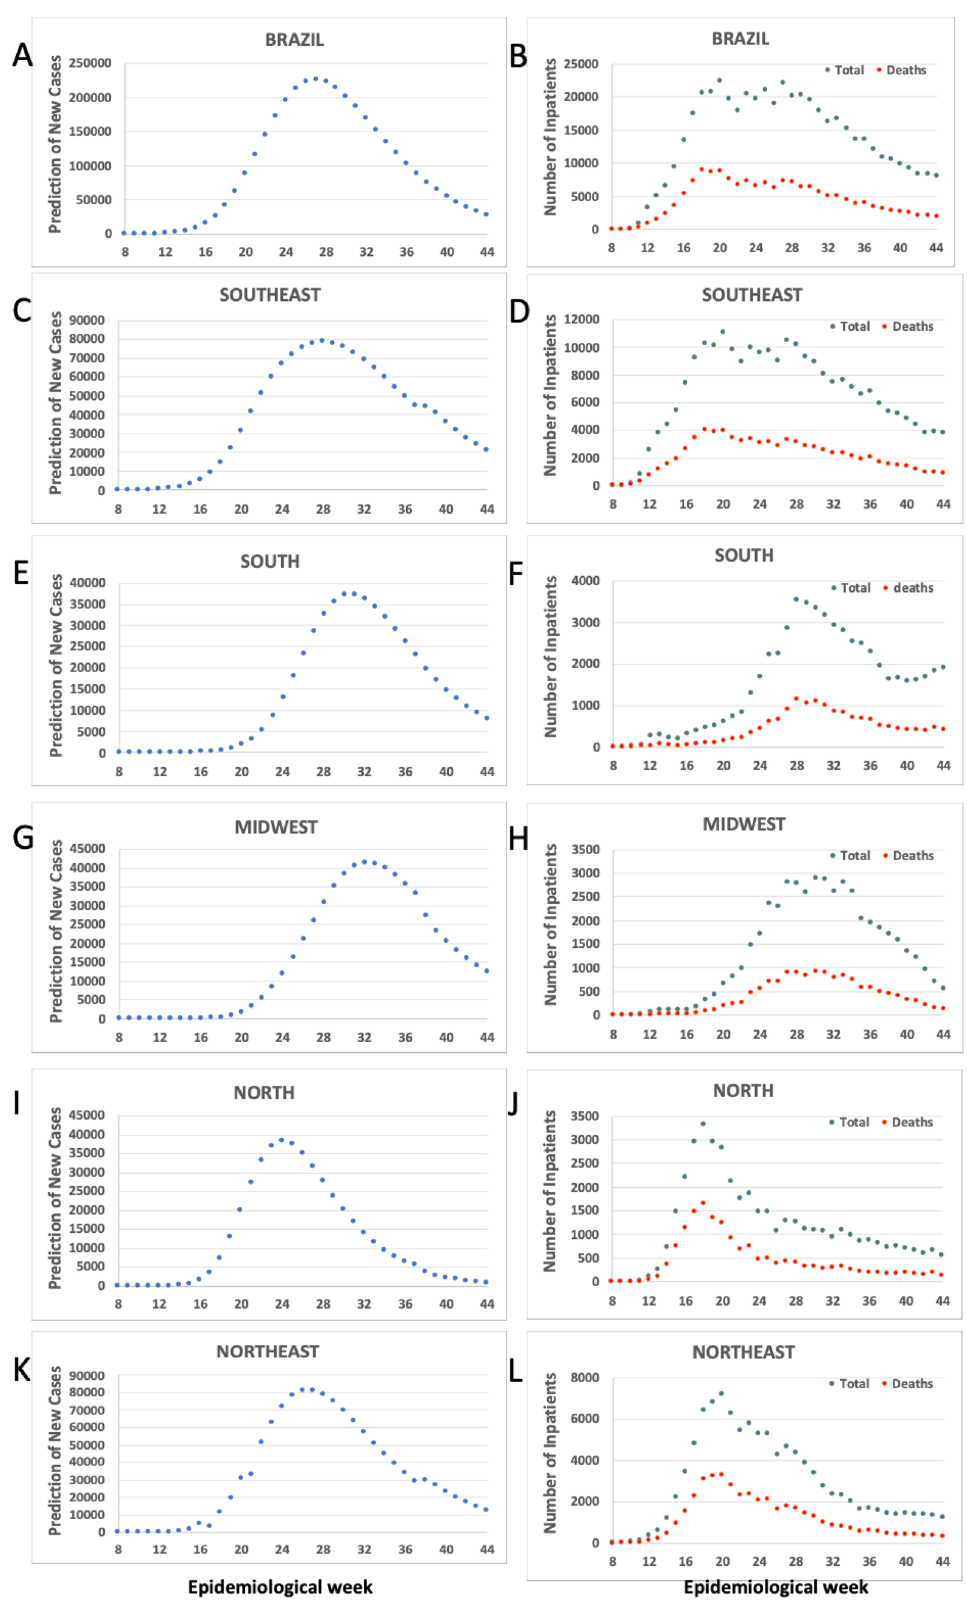
Figure 4. ( A ), ( C ), ( E ), ( G ), ( I ), ( K ): Prediction of new cases of COVID-19; and ( B ), ( D ), ( F ), ( H ), ( J ), ( L ): Total inpatients and deaths related to COVID-19 in Brazil and the five Brazilian regions: Southeast, South, Midwest, North, and Northeast. Analysis was performed from the 8th (Feb 16–22) to the 44th (October 25–31) epidemiological week of